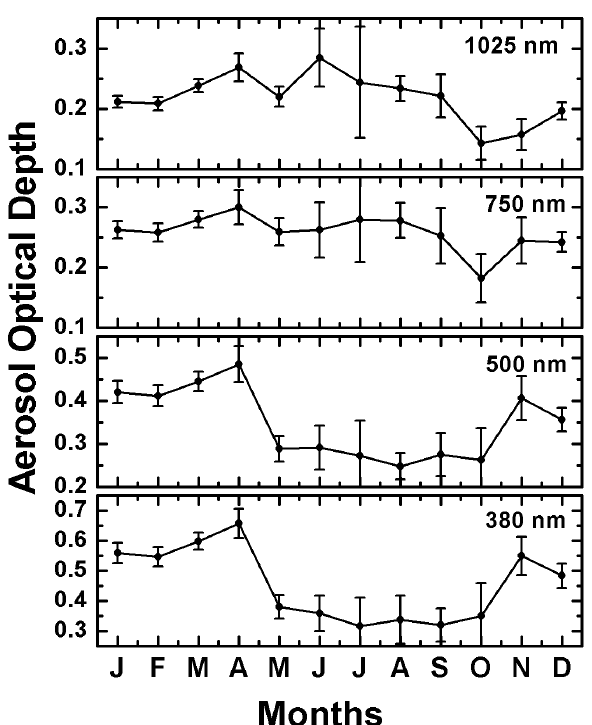
Fig. 4. Temporal variations of the monthly mean (averaged over 2000 to 2003) Aerosol Optical Depth (AOD) at Trivandrum, at four selected wavelengths; two in the visible and two in the near infrared. The vertical lines through the points represents the standard deviation of the mean.